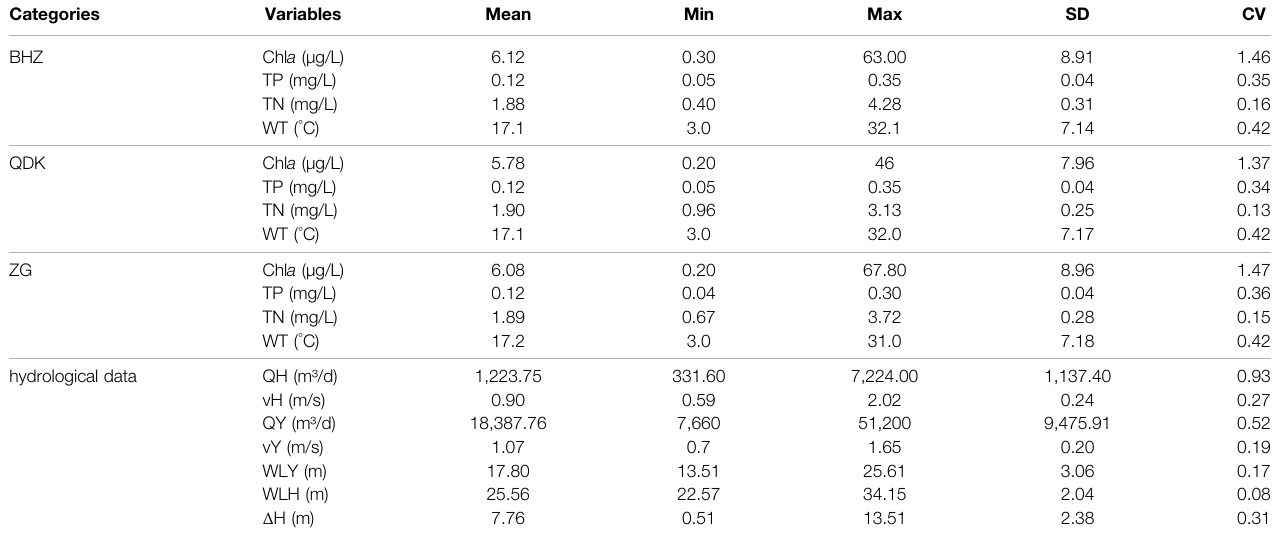
TABLE 1 | Mean, range (min, max), standard deviation (SD), and coef fi cient of variation (CV) of chlorophyll-a and the associated environmental factors during 2004 –